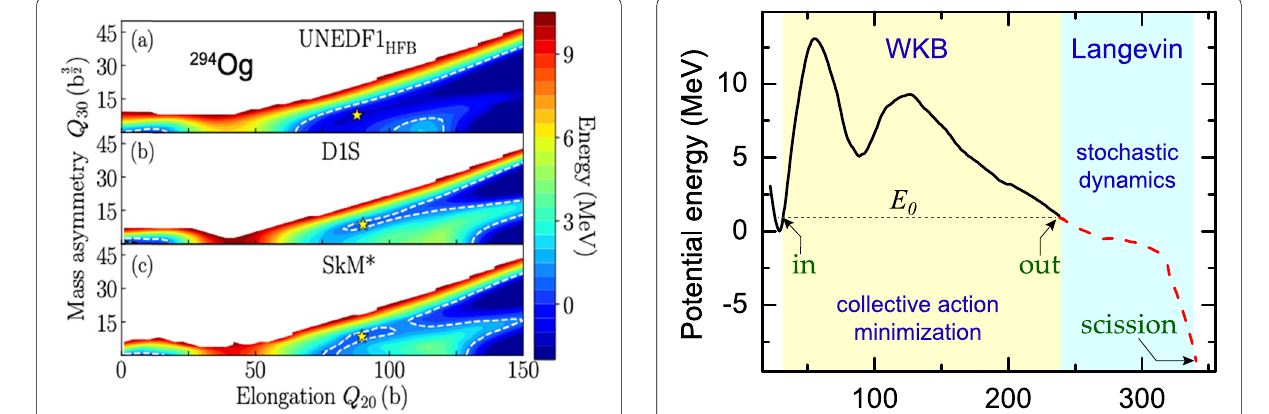
Fig. 7 2D Potential energy surface of superheavy element 294 Og, calculated with different density functionals as mentioned. The ground state energy E g . s . is normalized to zero. Dotted lines indicate E 0 E g . s . 1 MeV. The local energy minima at large deformations are − = marked by stars. The figure is adapted from [65]